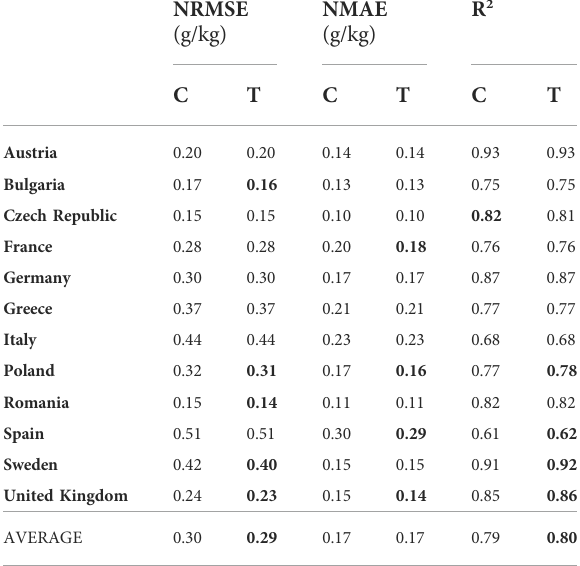
TABLE 2 Comparing classical (C), and transfer learning (T) approach in a Cropland-to-Cropland setting: normalized RMSE and MAE (lower is better), and R 2 (higher is